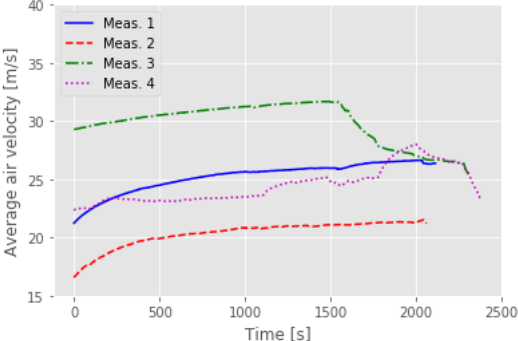
Figure 9. Temperature of the contacting surface of the seat for each